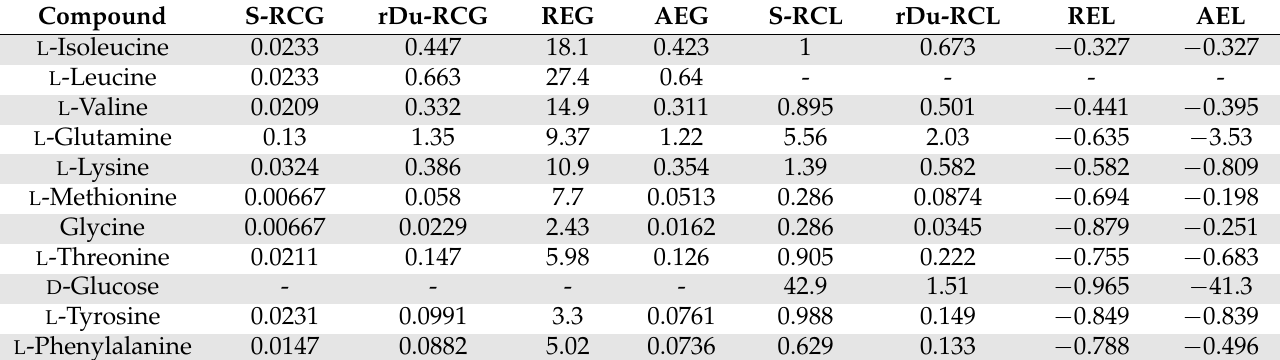
Table 7. Results from the rDolphin quantifier with the urine profile. The column headings are defined for this quantifier (with prefix rDu- ) analogous to the caption of Table 3.